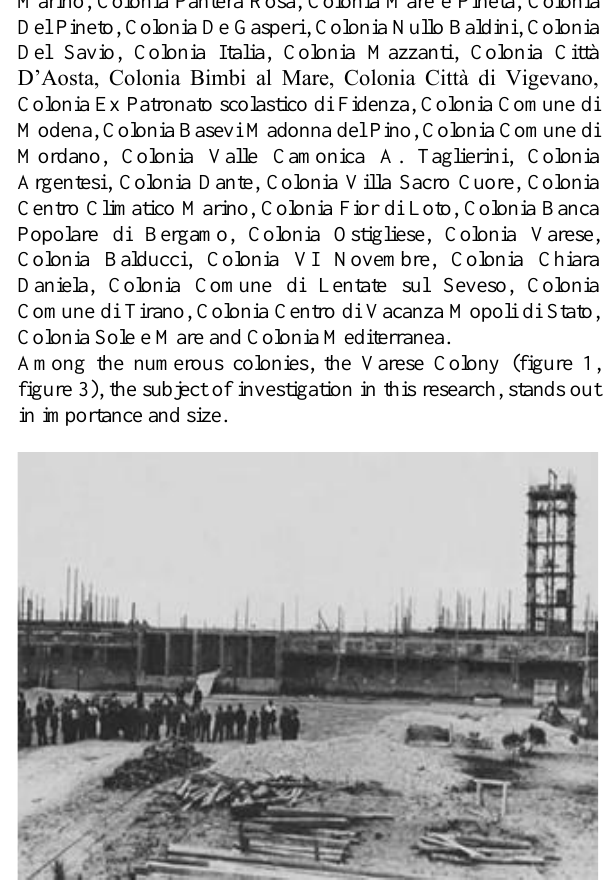
Figure 1 . Construction site of the Varese Colony,